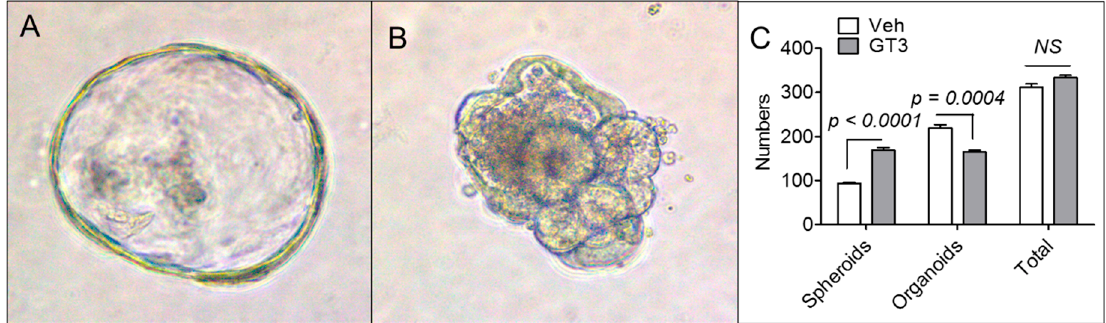
Figure 4. Effects of GT3 pretreatment on ex vivo intestinal organoid formation. ( A ) Representative photomicrograph of spheroid formed from intestinal crypt cells; ( B ) Representative photomicrograph of organoid formed from intestinal crypt cells; ( C ) Number of spheroids or organoids formed 7 days after exposure to 8 Gy TBI. Data represent the mean ± SEM. NS = not significant.